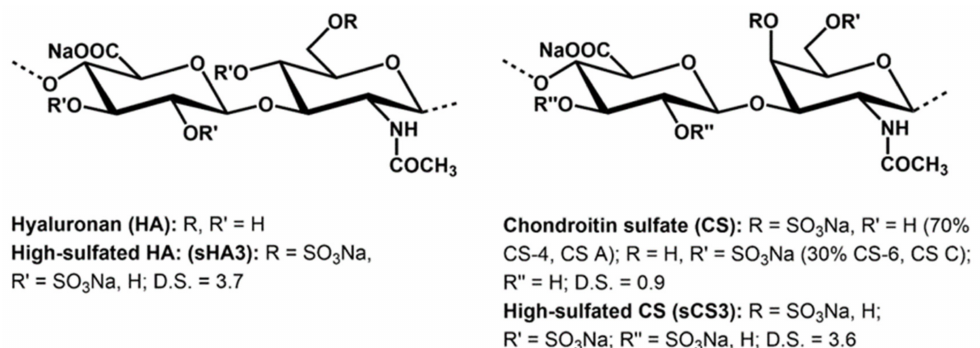
Figure 1. Structure of native and chemically sulfated GAGs (the used native chondroitin sulfate is a mixture of chondroiti-4-sulfate (CS A) and chondroitin-6-sulfate (CS C)). The D.S. (degree of sulfation) values are the average numbers of sulfate groups per disaccharide repeating unit.